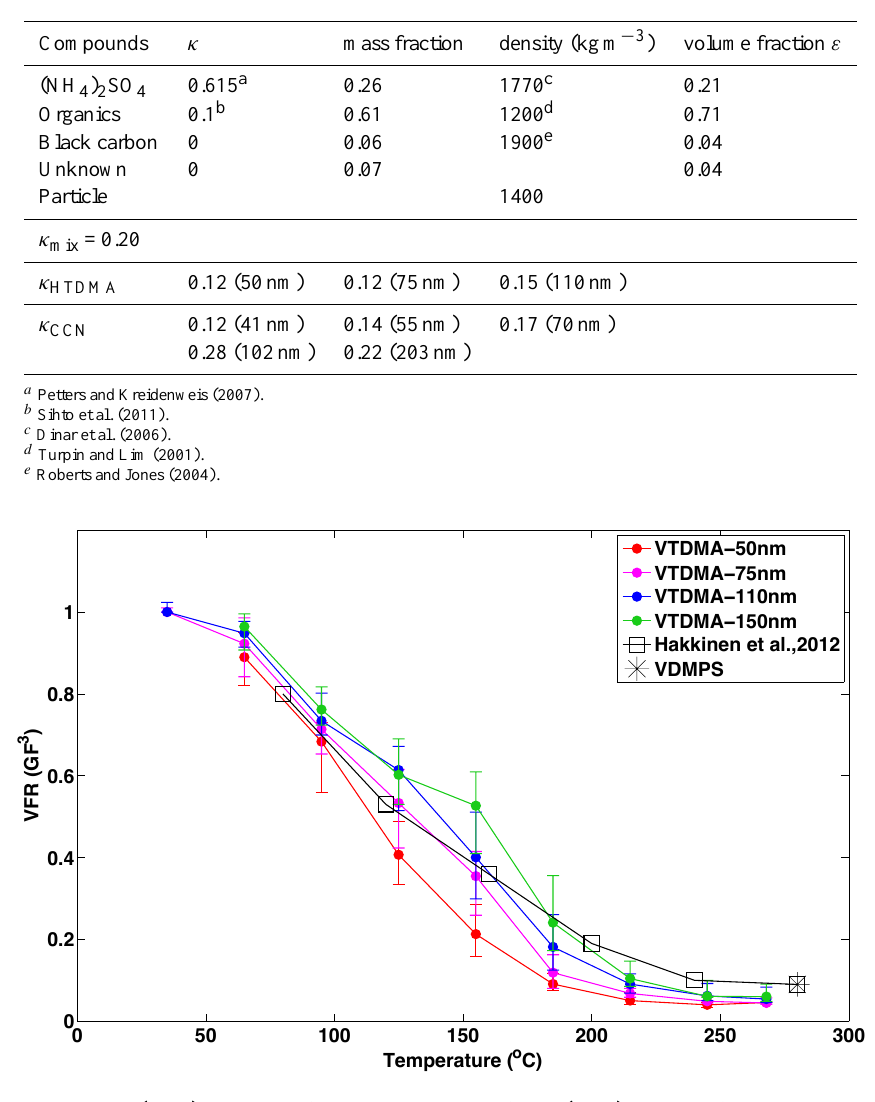
Fig. 6. Volume fraction remaining (VFR) calculated from volatile growth factor (GF V ) obtained from the VTDMA measurements as a function of heating temperature for four different particle sizes. In addition, VFR values from VDMPS analysis using data of HUMPPA- COPEC campaign (black star) and summertime data set used in Häkkinen et al. (2012) using VDMPS (black squares) are also